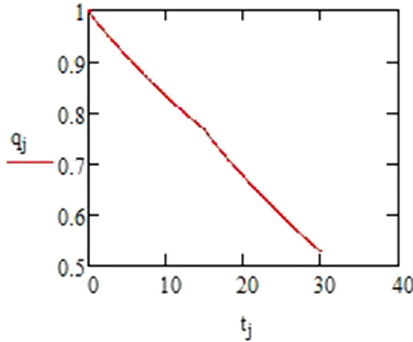
Fig. B1. Relative power vs. time.